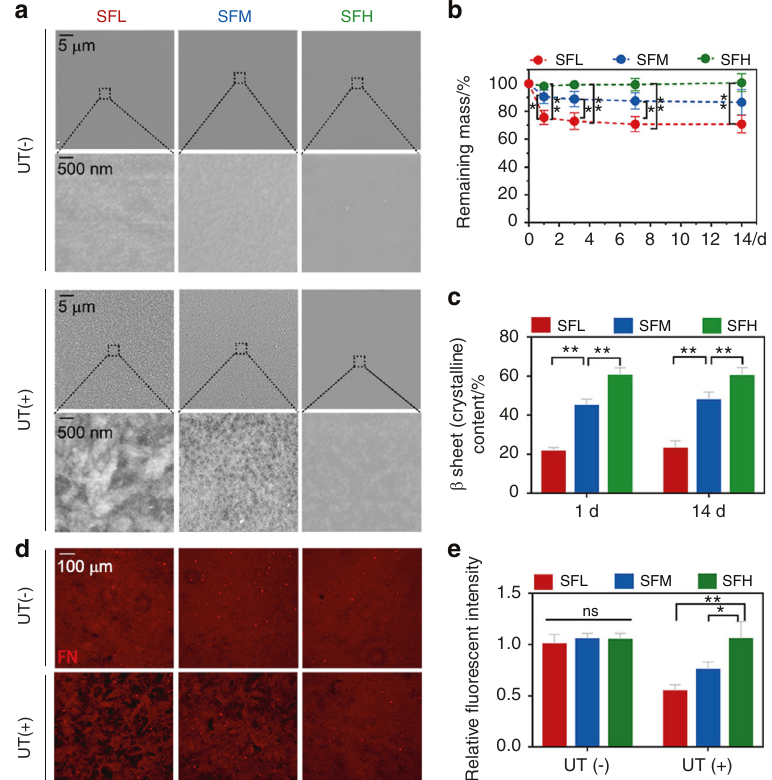
Fig. 2 Interfacial stability between different SF substrates and adsorbed FN. a SEM images of different SF substrates after being immersed in PBS for 24 h, with and without ultrasonic treatment (UT). b, c Remaining mass ( b ) and β -sheet contents ( c ) of different SF substrates immersed in PBS with UT treatment at speci fi c time points. d, e Immuno fl uorescence images ( d ) and the quantitative analysis ( e ) of adsorbed FN on different SF substrates after being immersed in FN solution for 24h, with and without UT treatment. Error bars represent one standard deviation. (* P < 0.05 and ** P < 0.01)